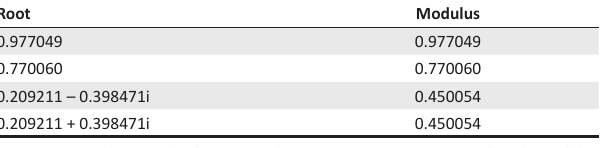
FIGURE 4: Cumulative sum of squares plots.